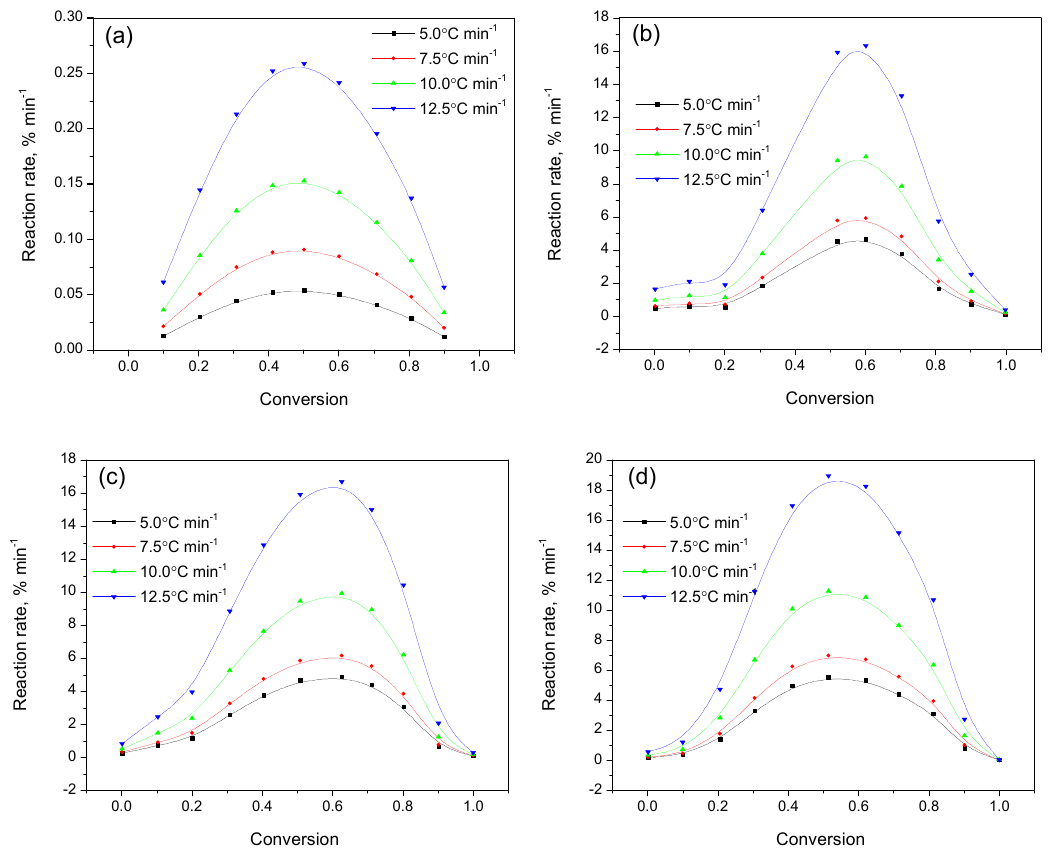
Figure 8. Series of reaction ( dα/dT ) speed curves of conversion rate ( α ) for p-PGFPh and p-